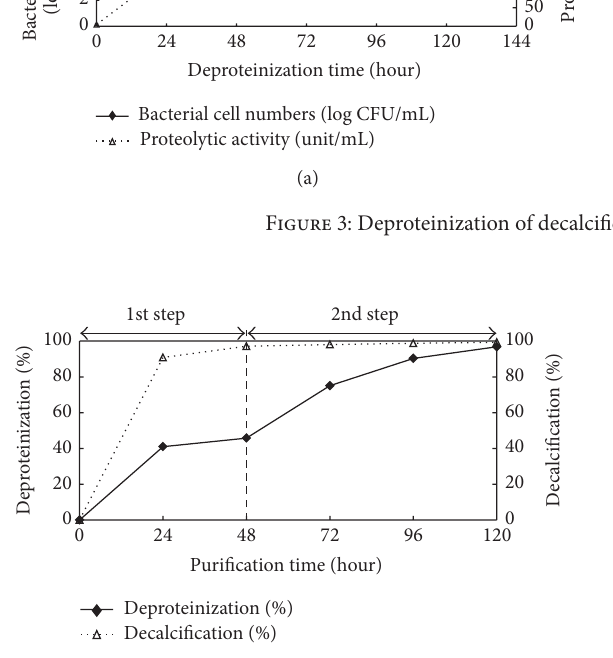
Figure 4: Deproteinization and decalcification efficacies from shrimpshellwasteduringthefirststepfermentationwith L.pentosus L7 and the second step deproteination with B. thuringiensis